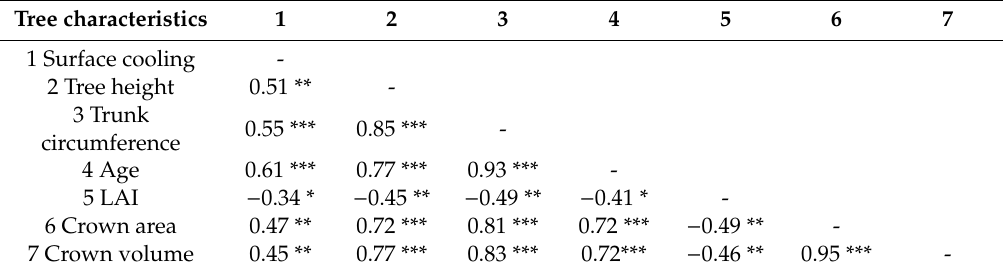
Table 3. Overview of correlations among the tree characteristics and surface